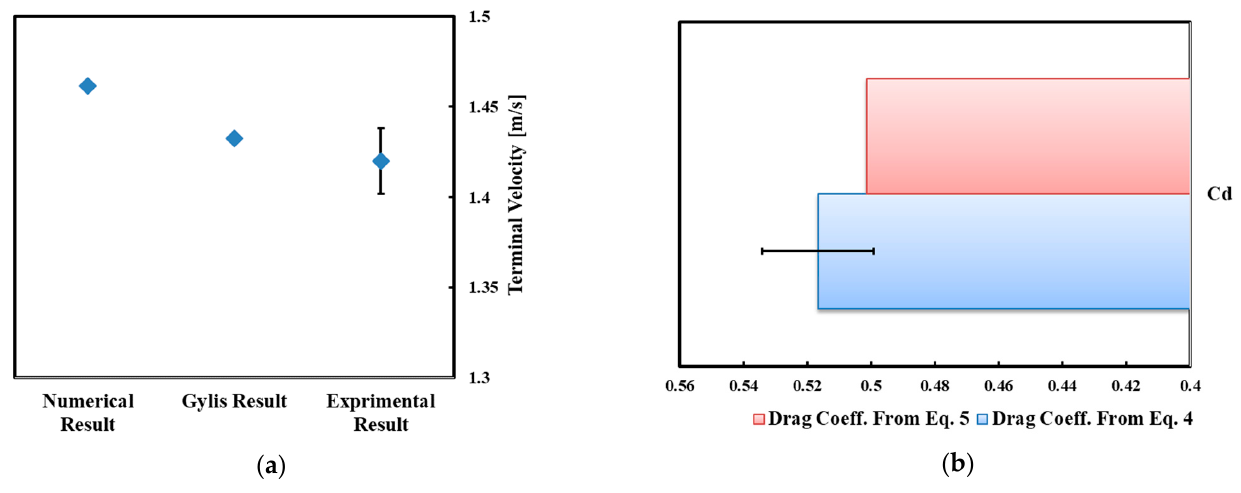
Figure 3. ( a ) The terminal velocity of the cold sphere and comparing the velocity to Gylys et al. [3] and the numerical data and ( b ) comparison of the drag coefficient obtained by the experiments and Equations (4) and (5).